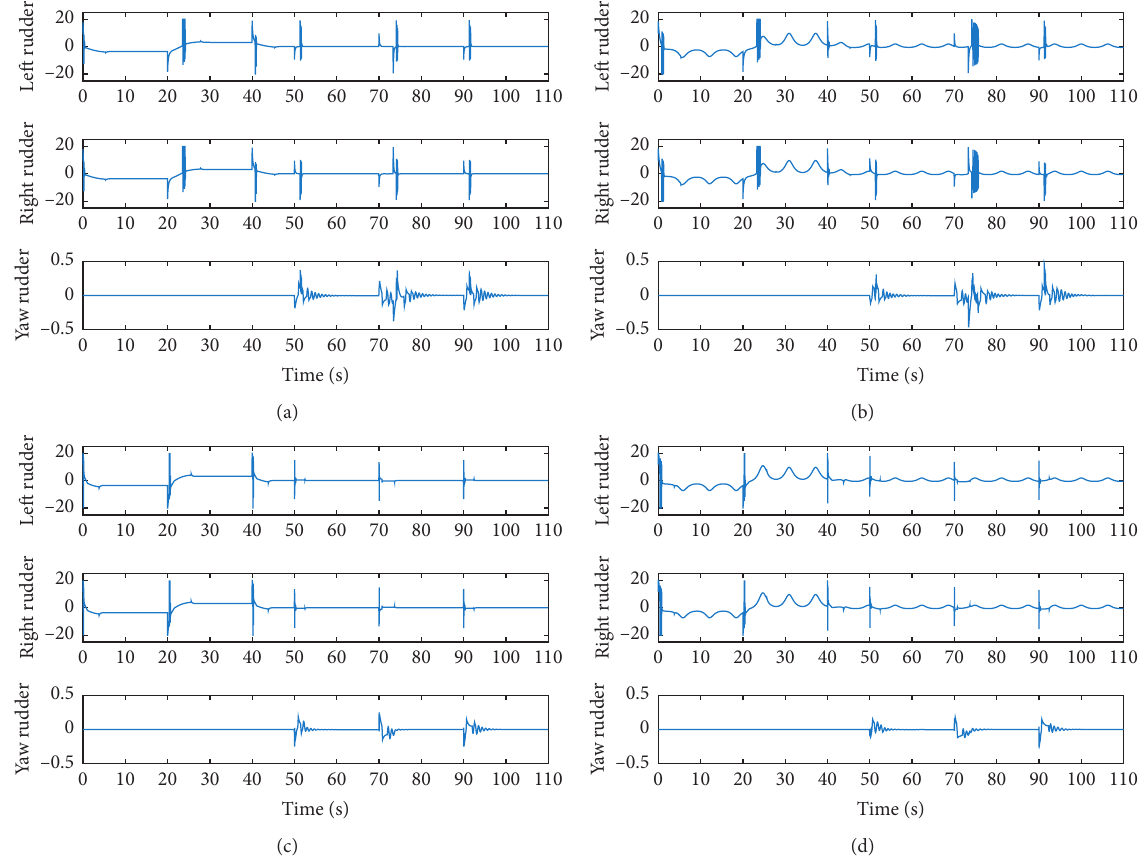
Figure 7: Steering curves of the servo in the four cases: (a) rudder deflection with baseline without uncertainties, (b) rudder deflection with baseline under uncertainties, (c) rudder deflection with optimal parameters without uncertainties, and (d) rudder deflection with optimal parameters under